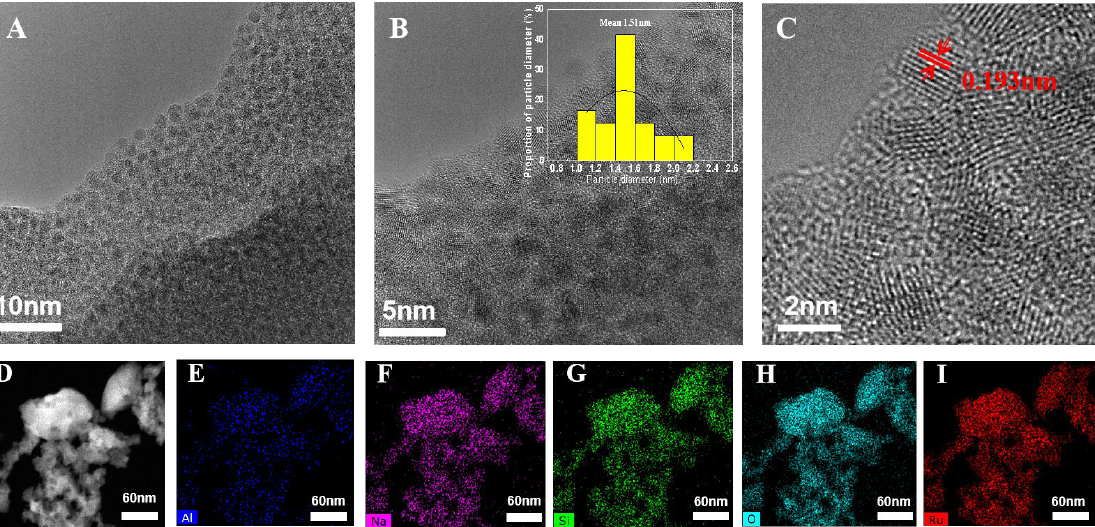
Figure 2. ( A – C ) HRTEM images of RuO 2 @FAU catalyst, and ( D – I ) HADDF scanning transmission electron microscopy image and energy dispersive X-ray spectrometry (EDX) mapping of RuO 2 @FAU catalyst for Al, Na, Si, O, Ru elements,